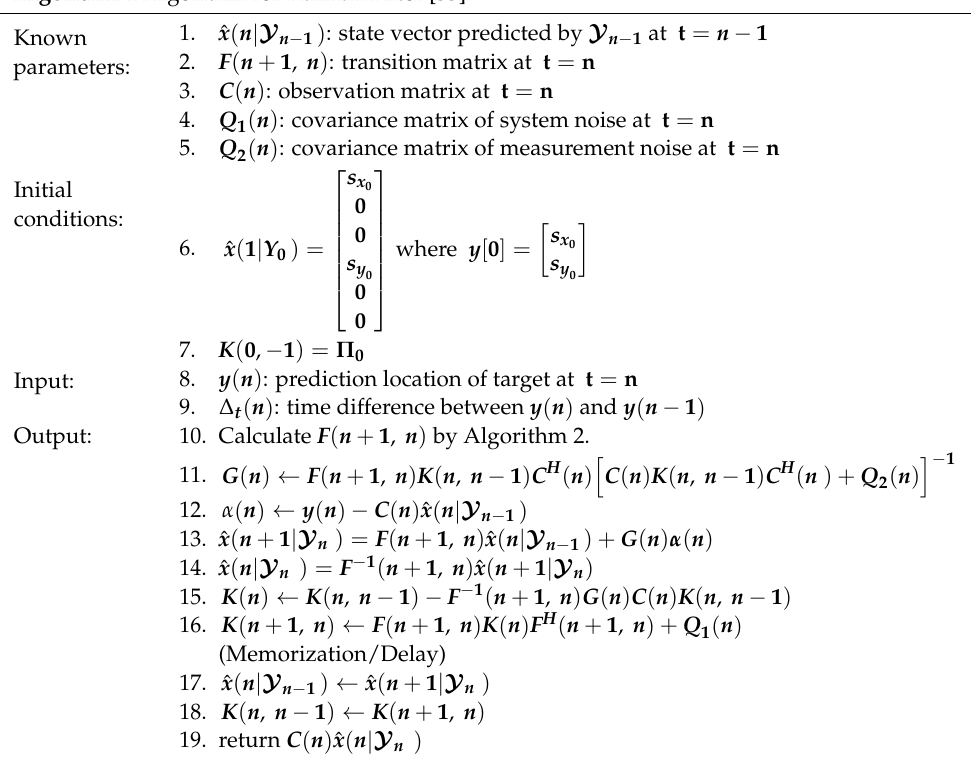
Algorithm 1 Algorithm for Kalman Filter